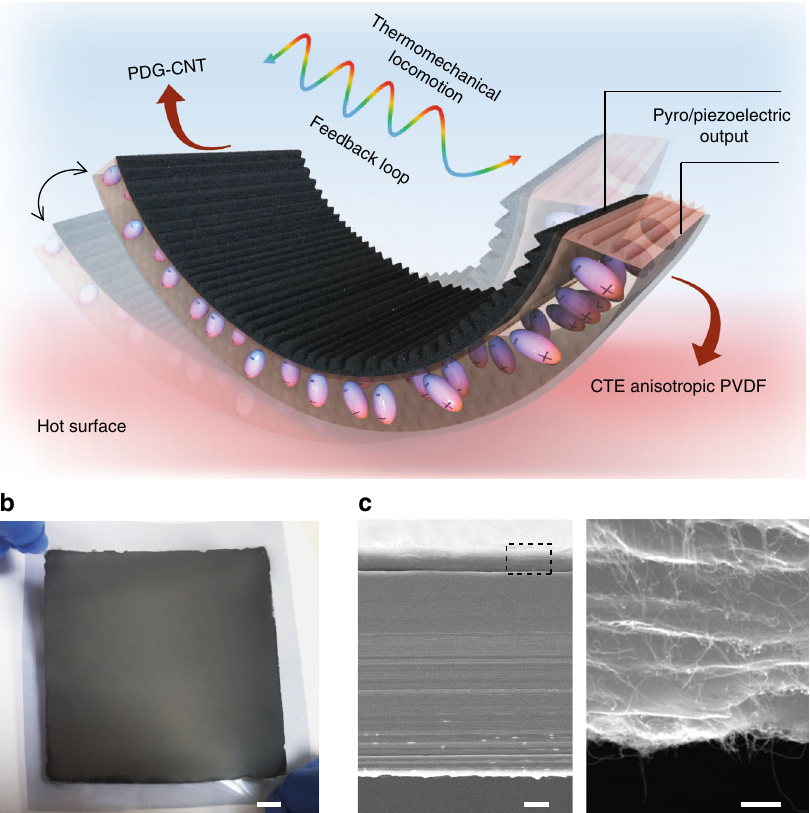
Fig. 1 The structure design and system concept of TMES. a Schematic illustration of the design concept of thermo-mechano-electrical conversion based on a bimorph actuator. b Photograph of a large-area TMES sample. c Cross-sectional scanning electron microscopy (SEM) image of PVDF/PDG-CNT bimorph (left) and magni fi cation of PDG-CNT nanocomposite layer (right). The scale in b , left and right of c are 1 cm, 10 μ m, and 200 nm,